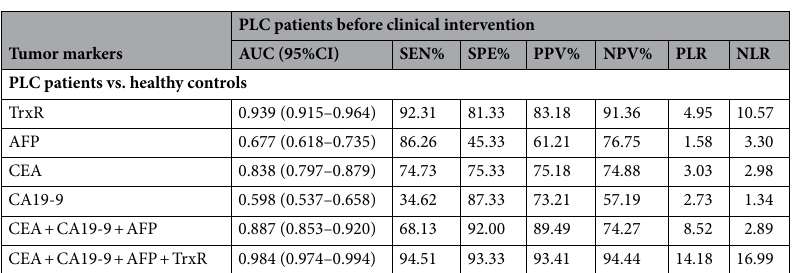
PLC patients before clinical intervention Tumor markers AUC (95%CI) SEN% SPE% PPV% NPV% PLR NLR PLC patients vs. healthy controls TrxR 0.939 (0.915–0.964)